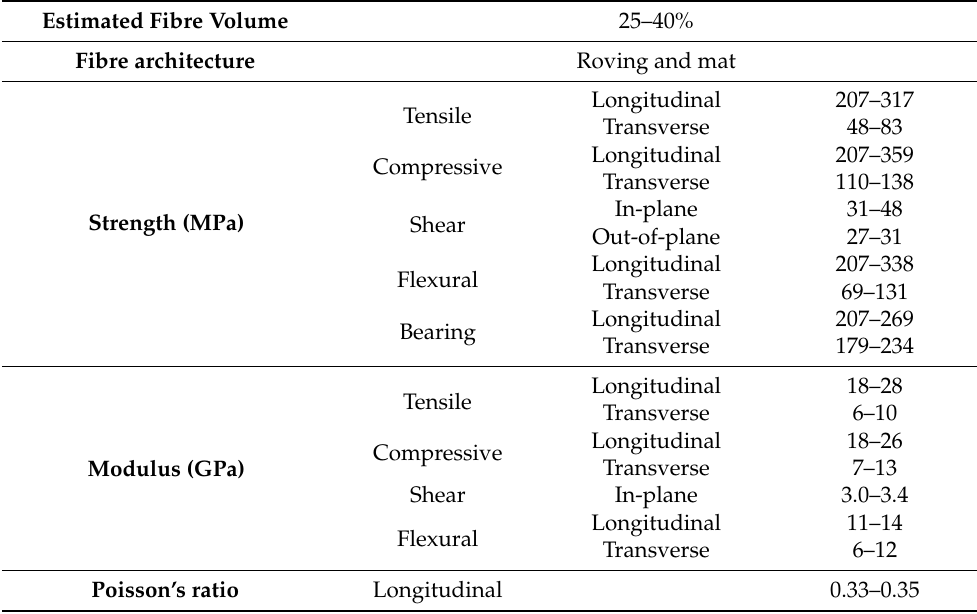
Table 2. Mechanical properties of pultruded FRP wide-flanged profiles (Glass reinforced Vinylester shapes 6–13 mm thick) [2,6,7].